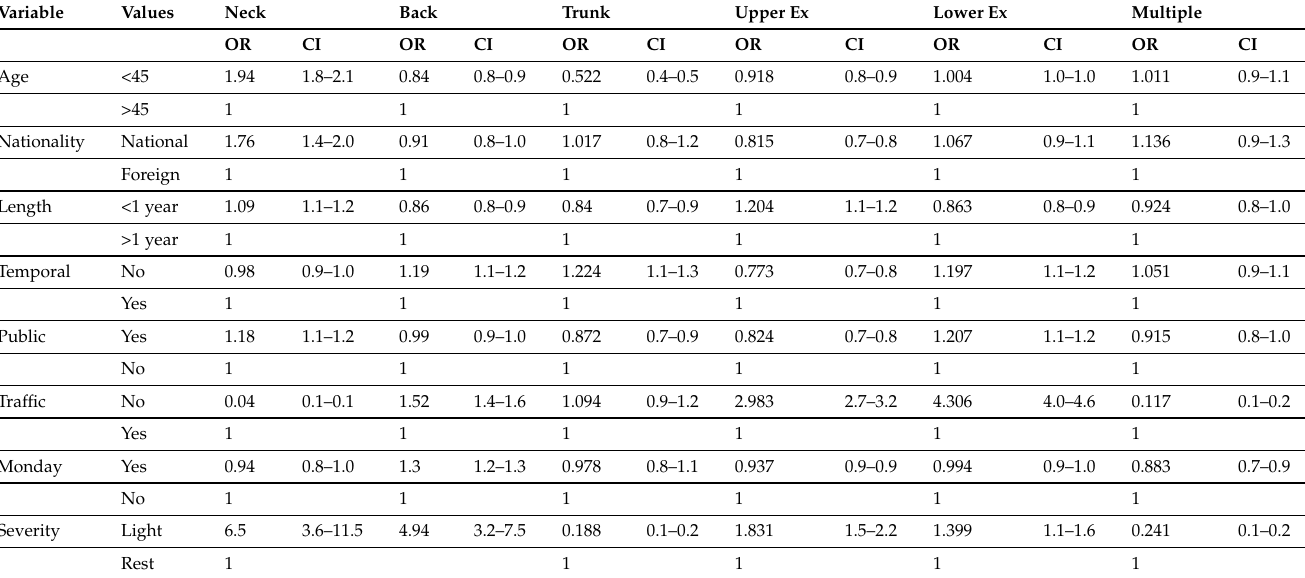
Table 1. Odds ratio estimated for occupational injuries